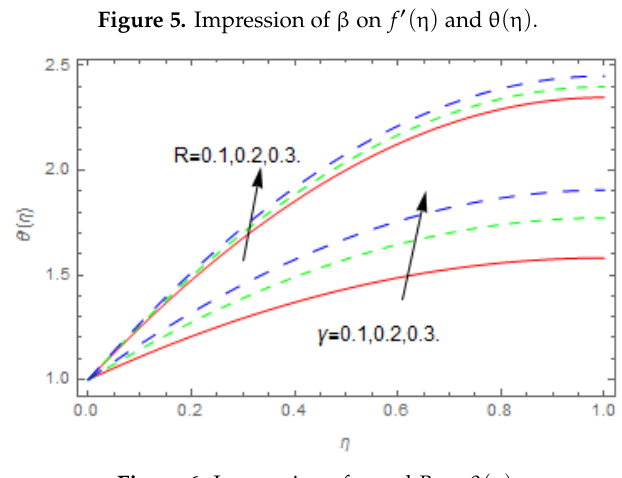
Figure 5. Impression of β on f (cid:48) ( η ) and θ ( η ) .